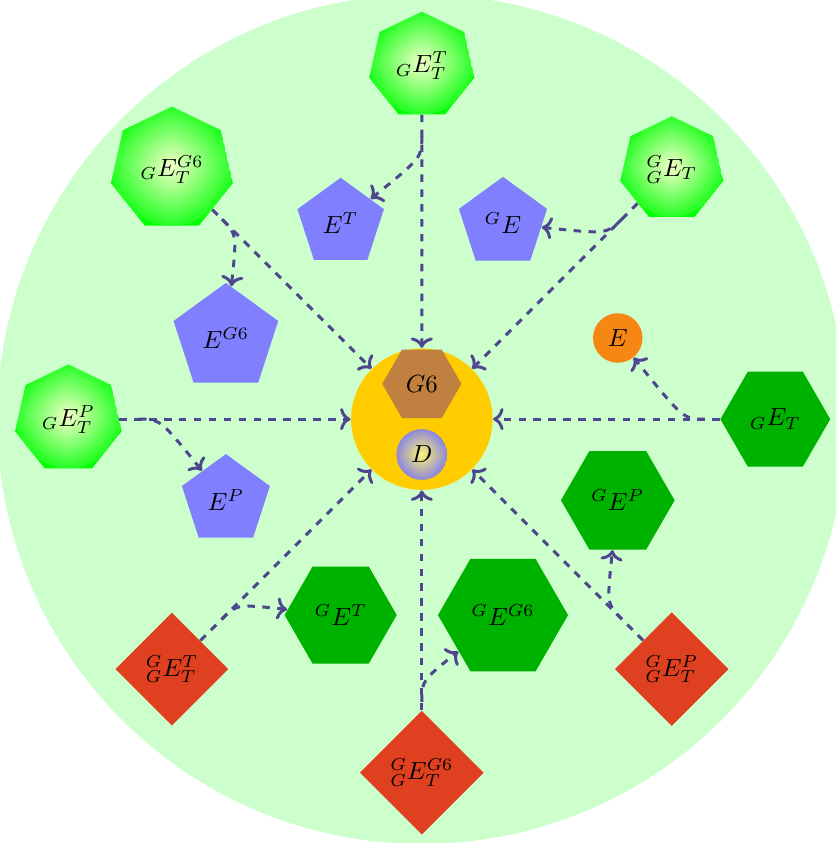
Figure 6. Diagram of chemical reactions producing the product. There are eight such reaction types, and each of them forms one G 6 P and one ADP molecule (denoted by D ) and either a free enzyme or an enzyme